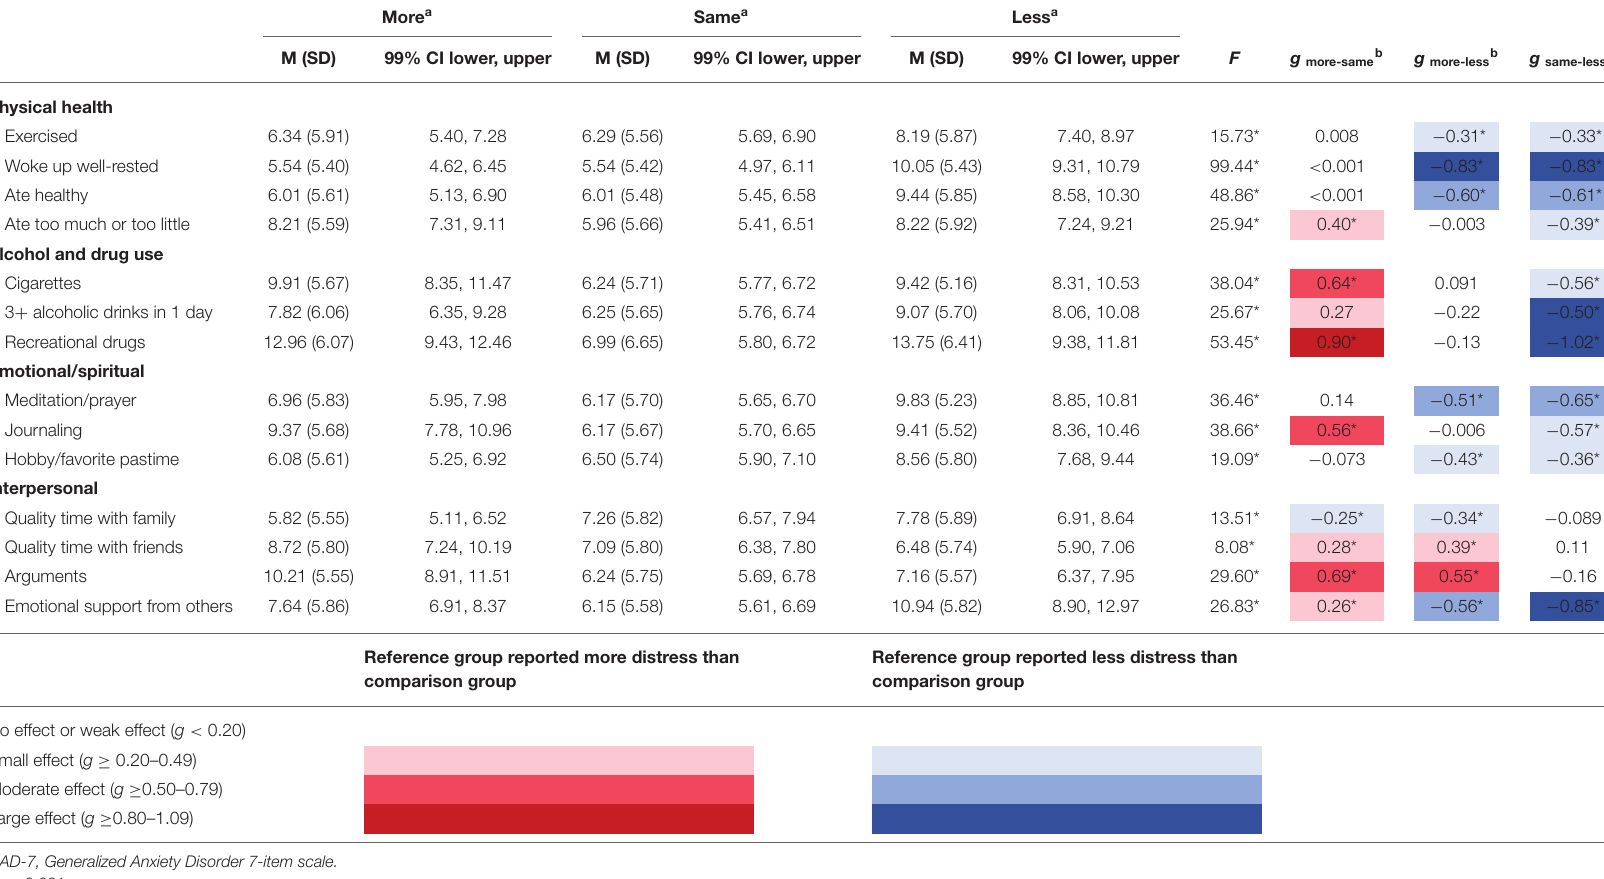
TABLE 3 | Associations between behaviors and generalized anxiety (GAD-7). More a Same a Less